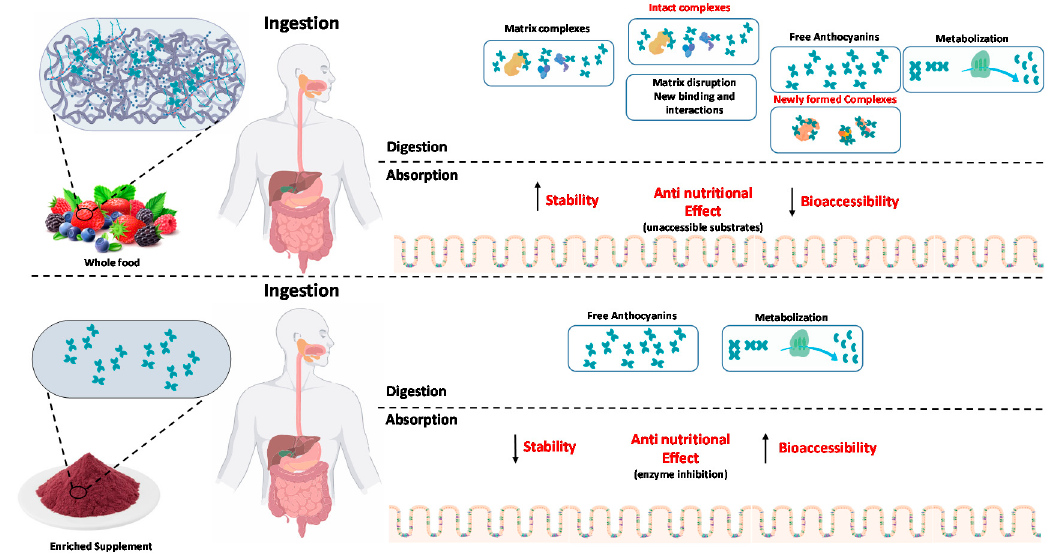
Figure 3. Impact of anthocyanin consumption within food matrix and as a supplement (individual compounds).